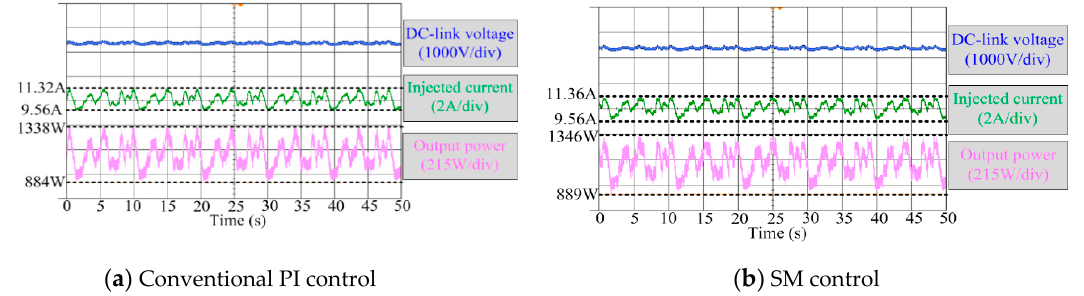
Figure 5. The experimental waveforms of the DC grid voltage, injected current, and output power of the entire WEC system for random wind profile under ( a ) proportional-integral (PI) and ( b ) sliding mode (SM) control.